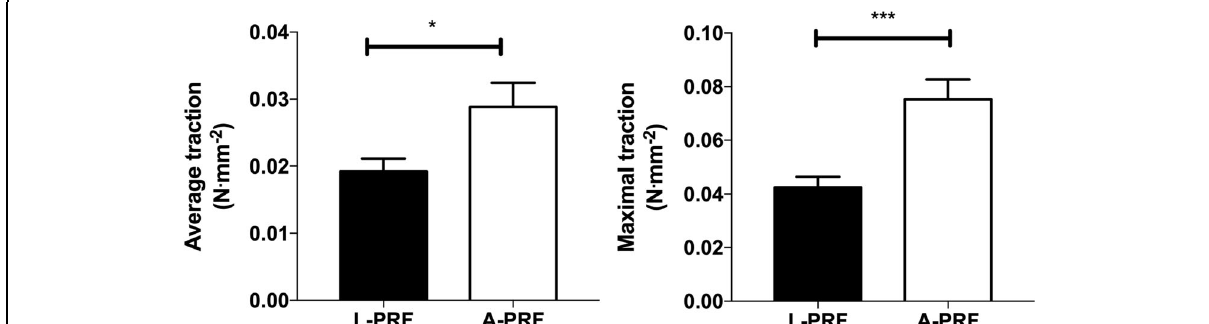
Fig. 5 Average and maximal traction values. a Average traction difference between L-PRF and A-PRF protocol (* p < 0.05 using unpaired t test n = 13). b Maximal traction difference between L-PRF and A-PRF protocol (*** p < 0.001 using unpaired t test n =